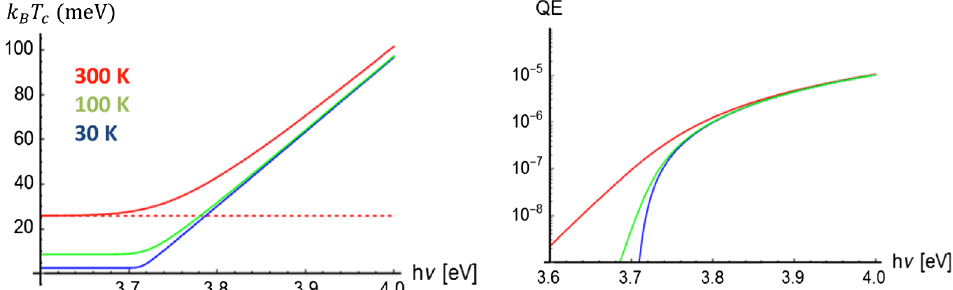
T FIG. 11. Photoemission temperature k (left) and quantum efficiency (QE) (right) as a function of photon energy, for atomically B c clean Cu [55] according to the relations given in [57,58], using an applied field of 250 MV = m. The scale of the quantum efficiency curve is such that at zero field, 270 nm photons produce a quantum efficiency of 10 − 5 , near what was attained in [90]. The energy at 300 K is shown by the dotted red